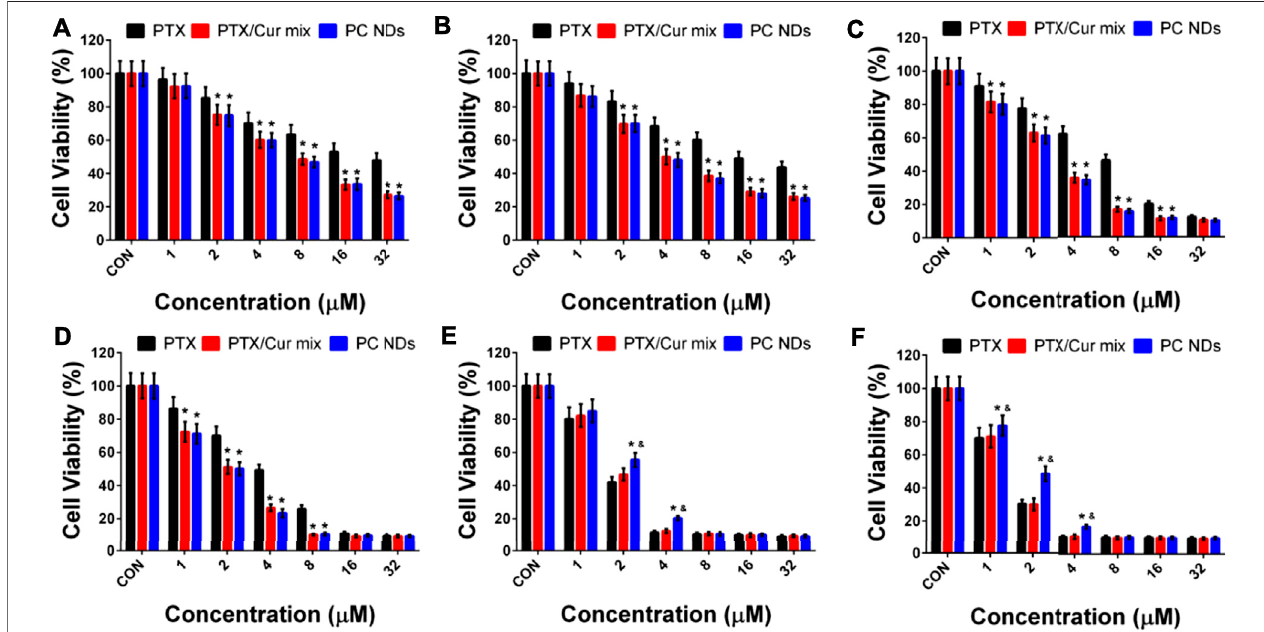
FIGURE4| CytotoxicityofPTX, PTX/Cur mix,andPCNDsin4T1,MDA-MB-231 andMCF-10A cellsafter 24and 48 hincubation. Cellviabilityof (A) 4T1cells, (C) MDA-MB-231 cells, and (E) MCD-10A cells after 24 h incubation. Cell viability of (B) 4T1 cells, (D) MDA-MB-231 cells, and (F) MCD-10A cells after 48 h incubation. Statistical signi fi cance: * p < 0.05 vs control and p < 0.05 vs PTX.